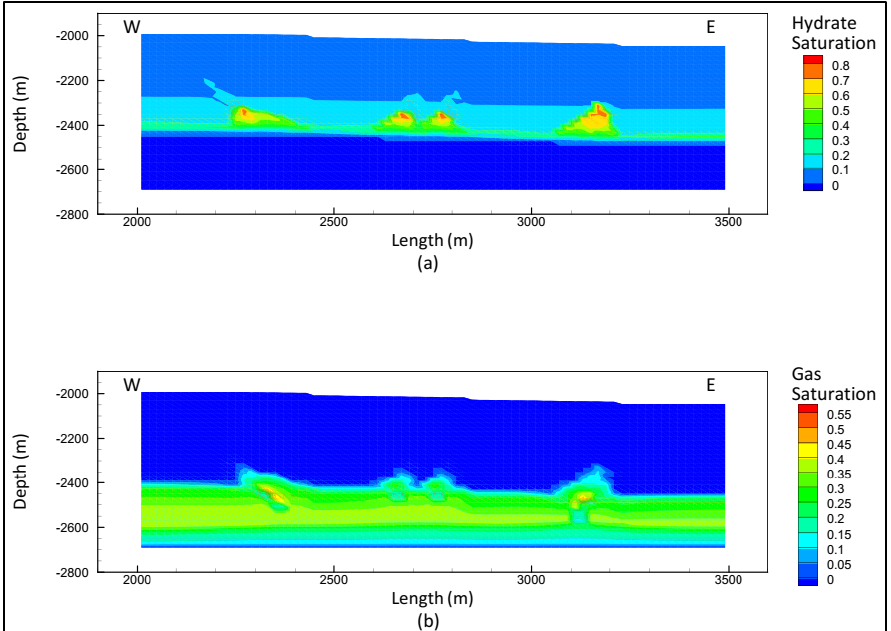
Figure 4. Hydrate formation after sixteen thousand years in the reservoir domain. ( a ) The hydrate saturation reaches a maximum of 78% and is distributed along the length of the reservoir model, with peaks along faults and highly permeable regions. ( b ) The underlying gas layer is typical in hydrate reservoirs at Green Canyon, with chimney structures forming around faults.